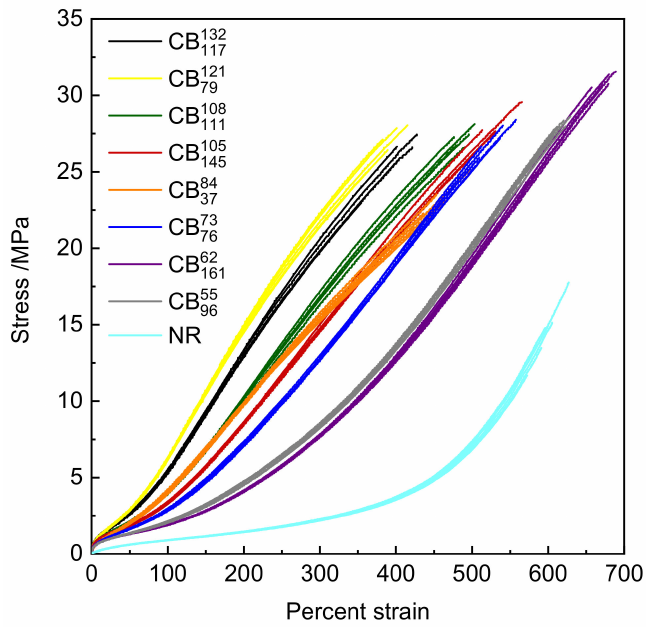
Figure 2. Stress–strain to failure data for the various rubber